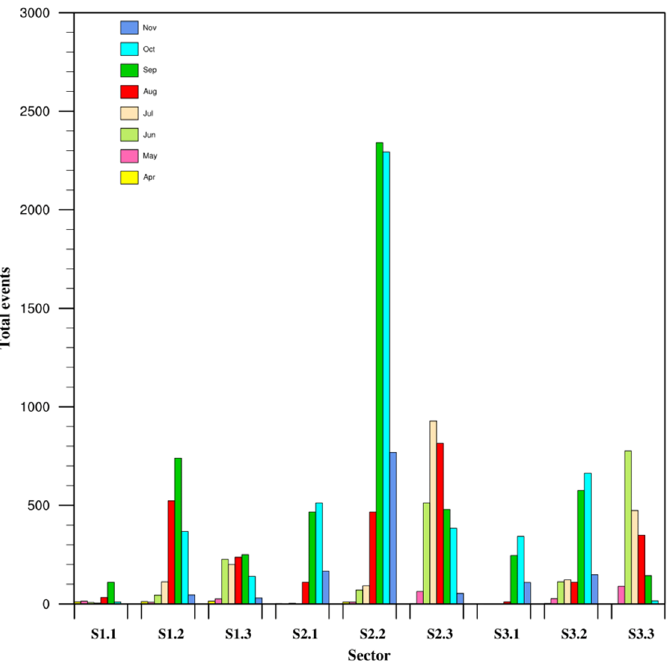
Figure 6. Total number of SH events in the period April-November from 1999 to 2021 for each sector of Figure 1.